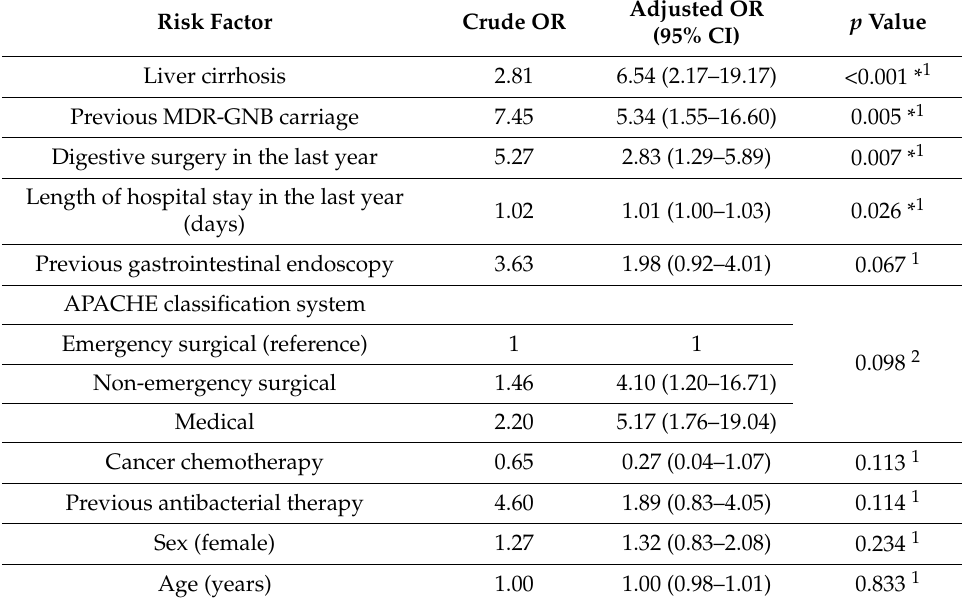
Table 3. Risk factors for MDR-GNB carriage upon ICU